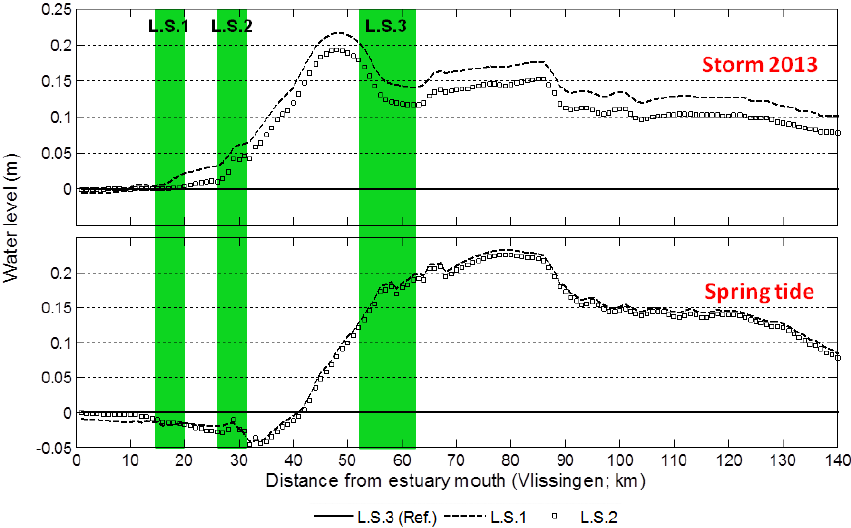
Figure 11. Scenarios with different wetland (with surface area = 3000ha) locations relative to reference scenario P.S.3 ( = L.S.3). Scenarios given for spring and storm (2013) tide. The green areas in the figure show the locations of the different wetlands along the estuary in the